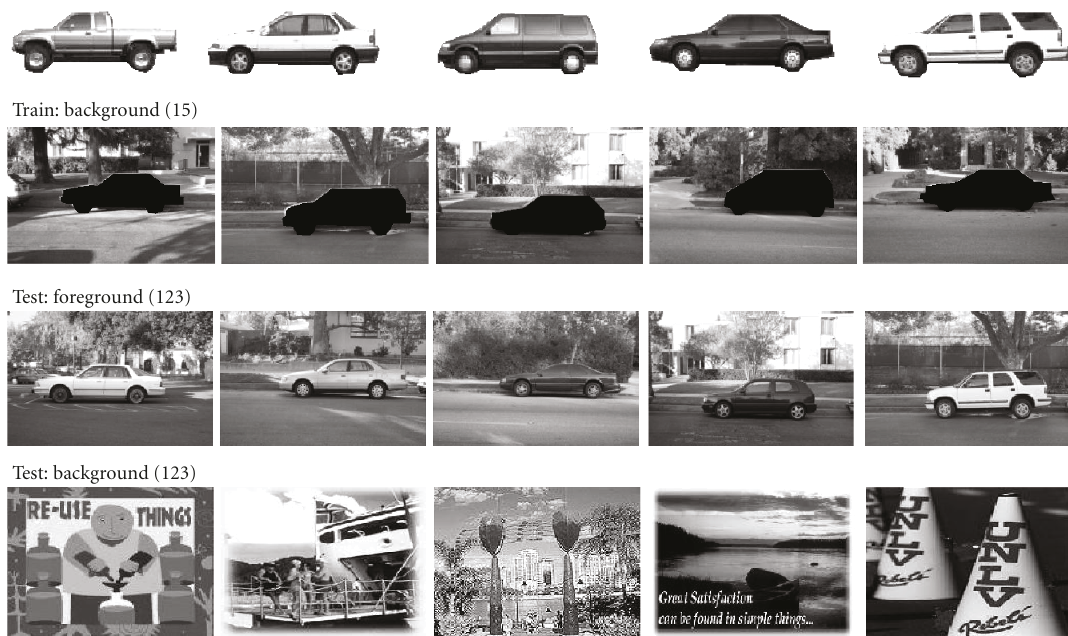
Figure 26: Partial examples of training set and test set for car category.